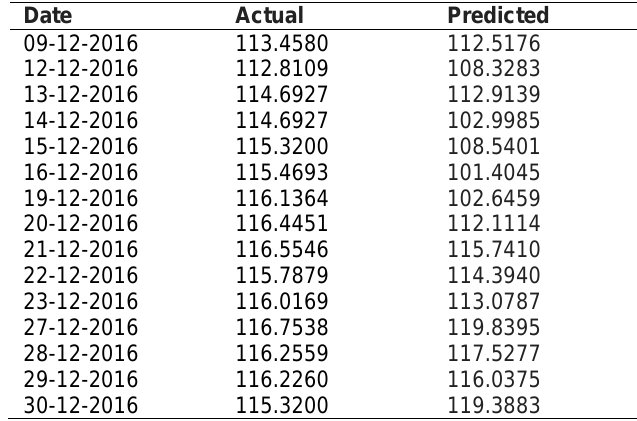
Table 10. Last 15 Actual and predicted values of the period 03-10-2016 to